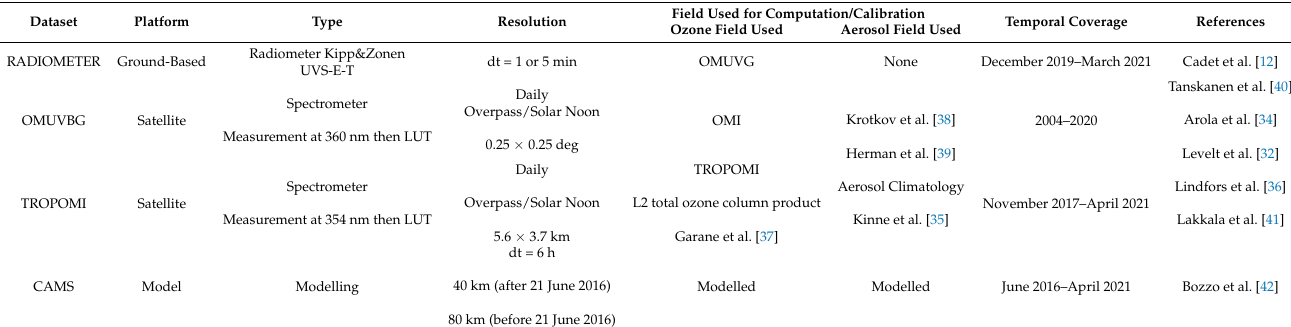
Table 1. Ground-based and satellite measurements of